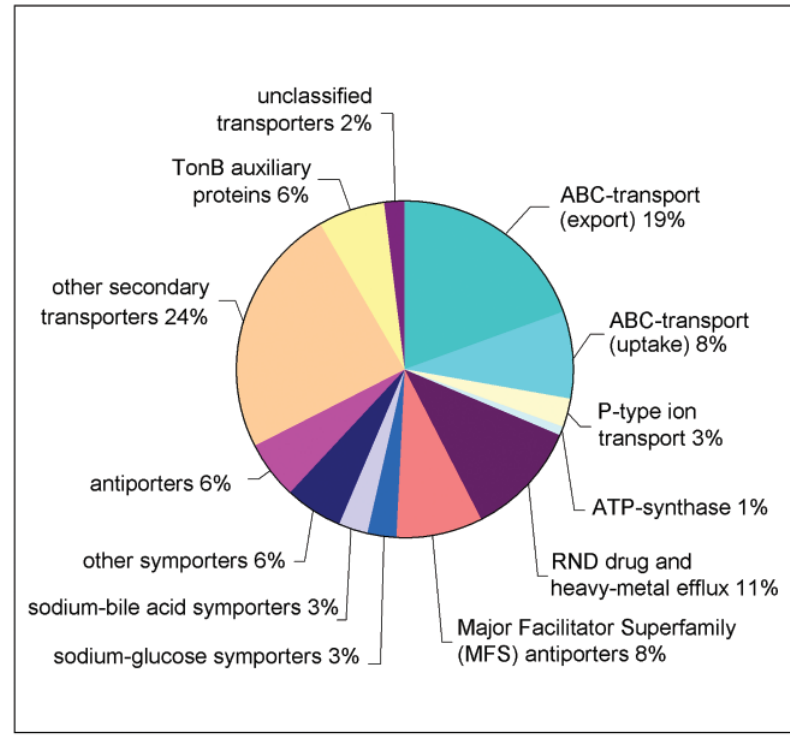
Figure 4. Major transporters of Leptospira inter- rogans . Major primary transporters are driven by ATP hydrolysis and include ABC-transporters, P- type ion transporters and the ATP-synthase. All other transporters indicated are the major sec- ondary transporters, which are driven by the transmembrane electrochemical potential. RND = resistance-nodulation-cell division